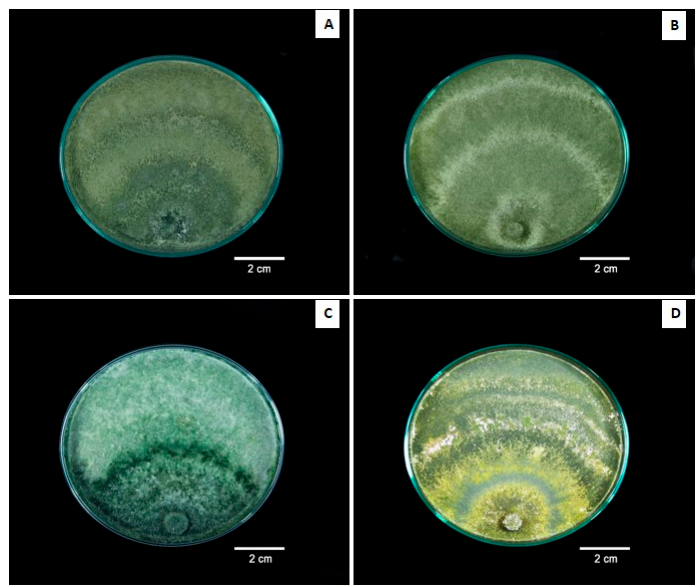
Figure A1. 15-day old Trichoderma colonies in potato dextrose agar (PDA) medium. ( A ) CP 10-3; ( B ) CP53-2; ( C ) CP24-6; ( D ) CP38-2.